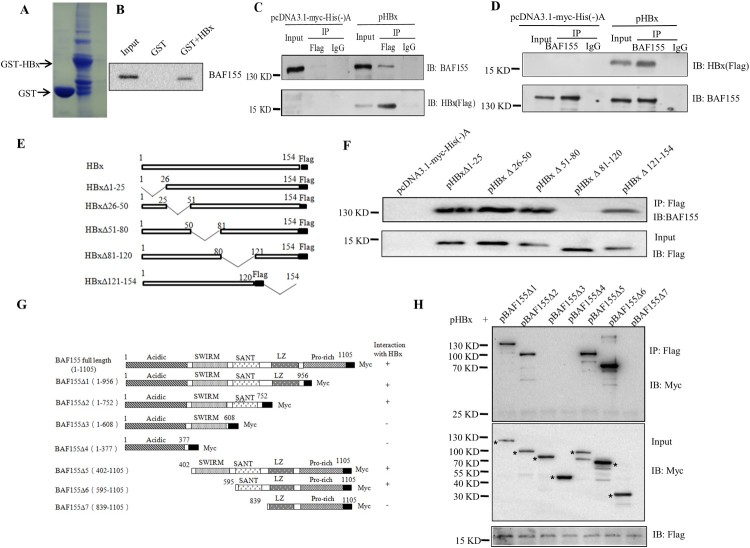
Interaction between HBx and BAF155. (A) Coomassie blue-stained SDS-PAGE gel showing bacterially expressed GST and GST-HBx recombinant proteins. (B) Representative autoradiogram of in vitro-translated 35S-BAF155 retained by GST-HBx fusion proteins from a GST pull-down assay. (C, D) Co-IP assay showing the interaction between HBx and endogenous BAF155 in Huh7 cells transfected with empty vector of pcDNA3.1/Myc-His(-)A or pHBx. The immunoprecipitation of BAF155 was detected for the presence of HBx and vice versa by western blot analysis. The input served as expression and specificity control for the individual proteins. (E) Schematic depiction of HBx and HBx mutants. The deleted region is indicated by a line with amino acid position on both ends. (F) Analysis of interaction between HBx mutant and BAF155 by Immunoprecipitation. (G) Schematic representation of wild-type BAF155 with the three major designated domains (SWIRM, SANT and LZ) and its various deletion mutants used in this study. All mutants were fused to Myc epitope at the C terminus. (H) Whole-cell extracts were prepared from Huh7 cells transiently transfected with pHBx and various BAF155 mutant expression vectors and immunoprecipitated with Myc antibody. The bands corresponding to the expected BAF155 protein are marked with dots. About 10% of the total input lysates used for immunoprecipitation were directly analyzed by western blotting with anti-Flag antibody (bottom panel).